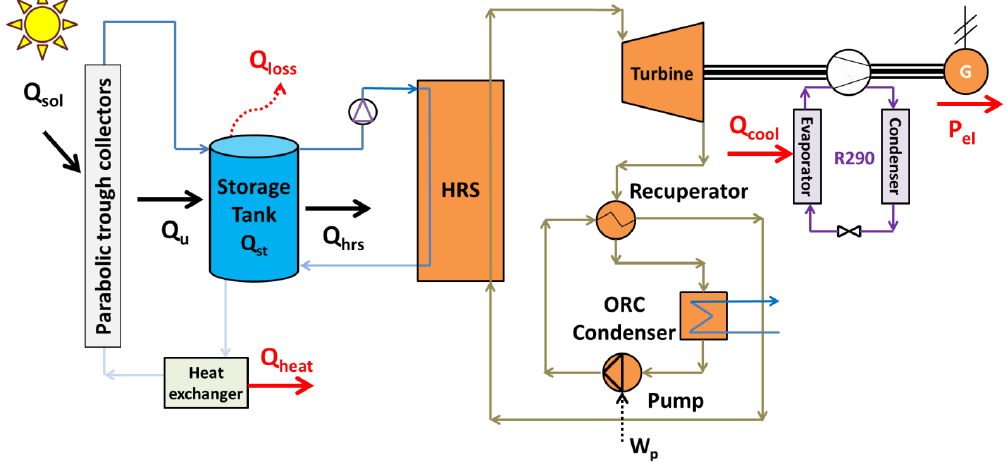
Figure 3. System 3 — The ORC is fed with electricity the VCC.